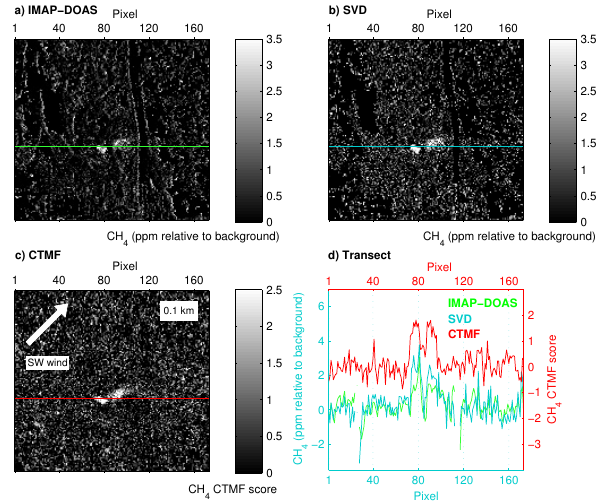
Fig. 15. For the same Inglewood subset, there is good agreement between results obtained using three techniques: (a) IMAP-DOAS, (b) SVD, and (c) cluster-tuned matched filter (CTMF). (d) The lo- cation of a horizontal transect is shown for the IMAP-DOAS (green line), SVD (cyan), and CTMF results (red); values along the tran- sect are shown for IMAP-DOAS (green), SVD (cyan), and CTMF (red) approach. At each point along the transect, an average value was calculated for 9 pixels centered on the transect in the vertical di- rection. IMAP-DOAS and SVD transects share the cyan figure axes, while the CTMF transect was offset for clarity and corresponds to the red figure